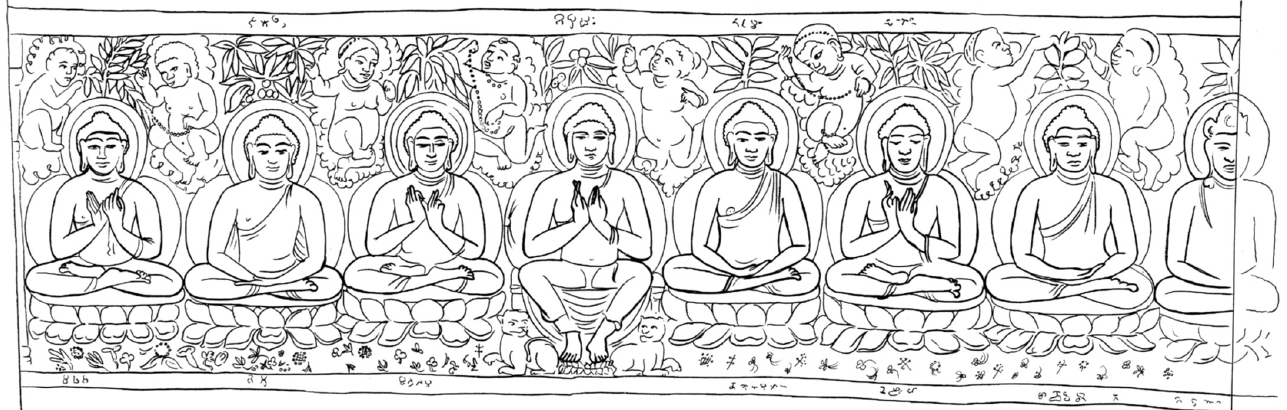
Figure 10. Line drawing of a mural painting of the seven past Buddhas, plus Maitreya, and their respective bodhi -trees from Aja ṇṭ ā Cave 22, ca. 478–480 CE (After Zin 2003, vol. 2, pl. 37a). respective bodhi -trees from Ajan.t.¯a Cave 22, ca. 478–480 CE (After Zin 2003, vol. 2, pl.